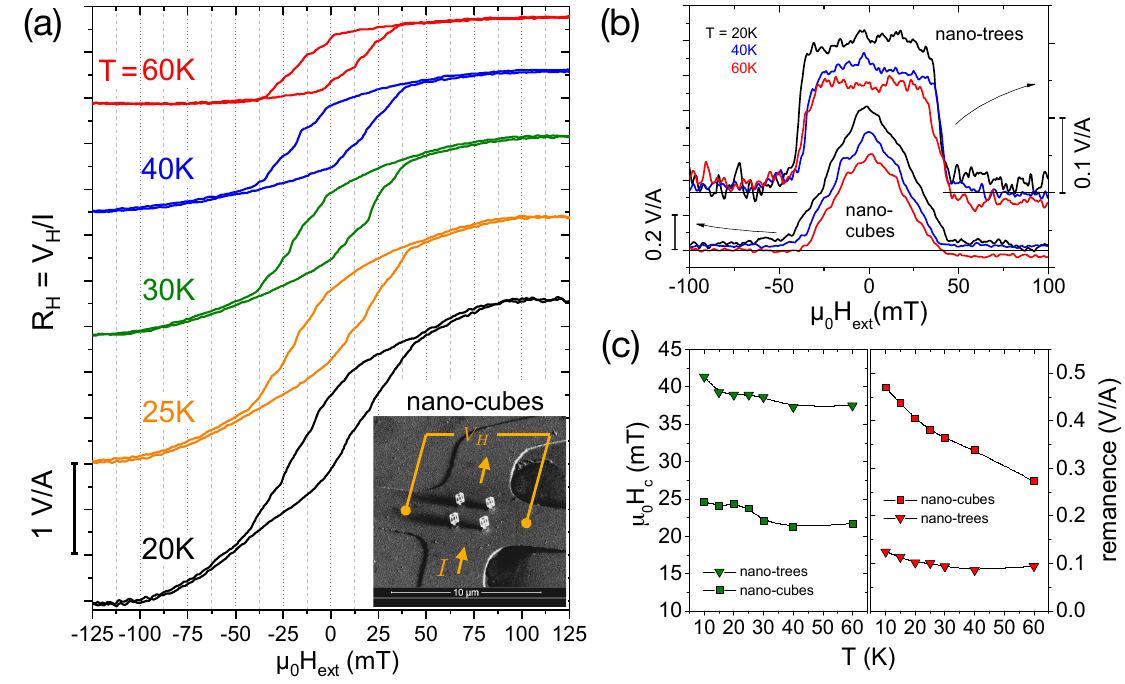
Figure 2. ( a ) Temperature dependence of the CoFe nanocubes’ magnetic hysteresis loop. Inset shows an SEM micrograph of the corresponding Hall cross and the Hall measurement configuration; ( b ) ’Area’ of the hysteresis loop (up- minus down-sweep) for the nano-cubes and -trees at selected temperatures; ( c ) Temperature dependence of the switching field ( left ) and zero-field stray field magnitude ( right ) corresponding to coercivity and remanence, respectively, of both nano-cubes and